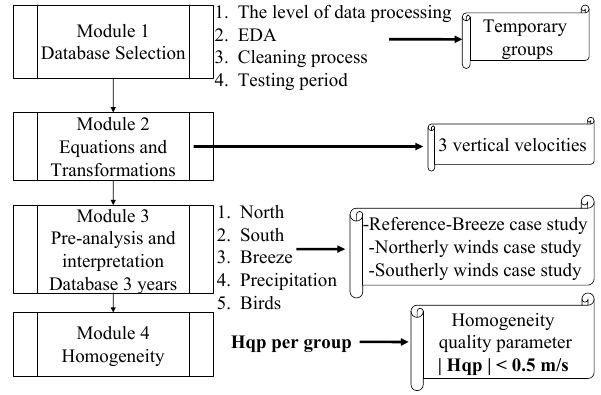
Fig. 2. Schematic overview of the methodology used in the